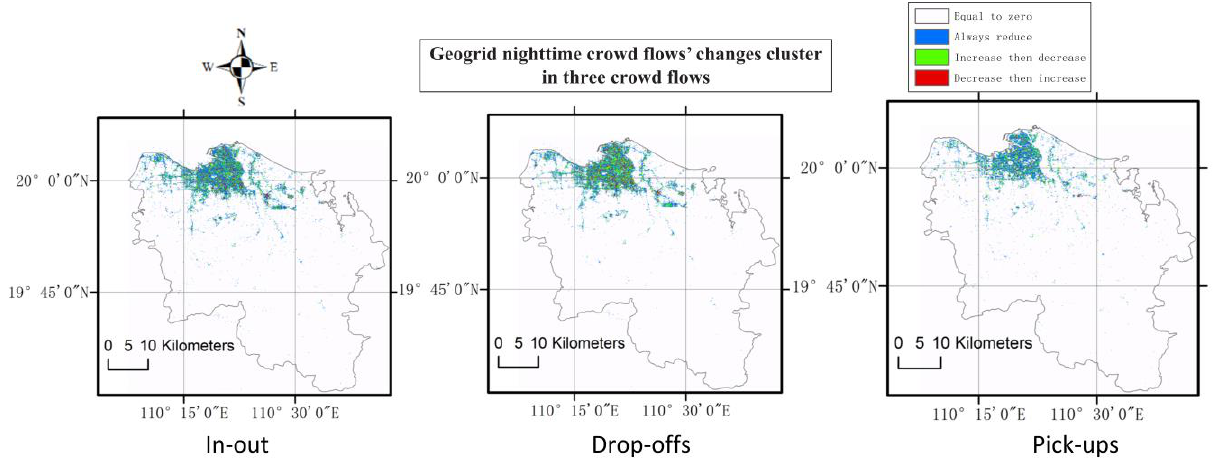
Figure 6. Crowd flows’ changes in each geogrid at night in Haikou. The clustering results of crowd flows in the city are distinctive according to three different crowd flows.